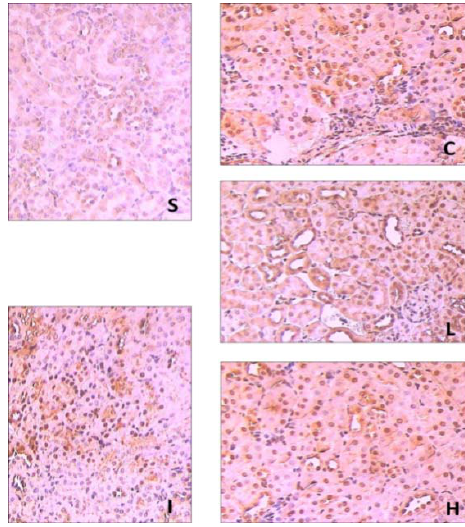
Figure 3. Immunohistochemical staining of HO-1 and Nrf2 expressions in the renal tissues in the groups (IOD × 10 3 ). * p < 0.05 vs. sham group, # p < 0.05 vs. IIR